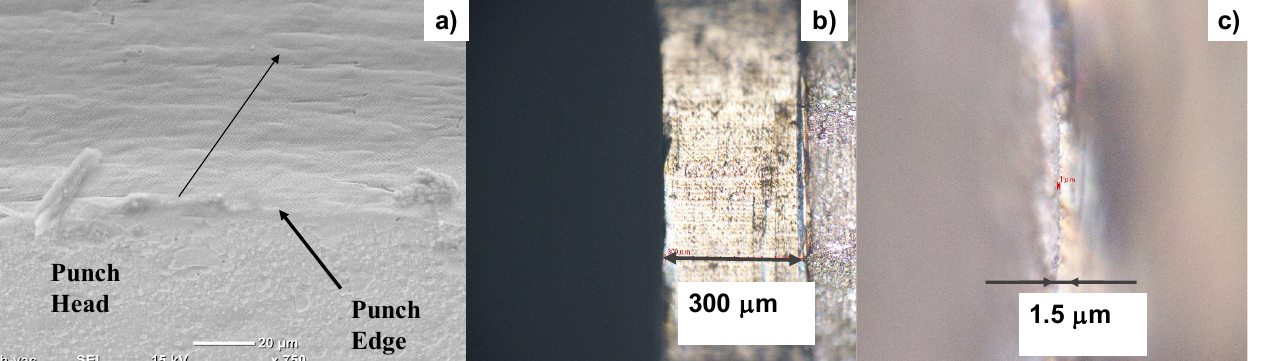
Figure 11. SEM and YAG-BSE images on the top and side surfaces of laser-trimmed SKD11 punch across its edge ( a , b ) in low magnification, and ( c , d ) in high magnification. 3.4. CNC Stamp Imprinting to Metallic Products An AA1060 aluminum plate with a thickness of 1mm with a normal flow stress of 200 MPa was employed. The CNC stamping system was utilized to imprint seven micro- textures with the tailored nano-textures onto this substrate. A single-mode loading se- quence was used to compress the upper punch with a constant velocity. Figure 12 depicts the embossed AA1060 aluminium plate after single-shot loading down to 150 μm from the original position where the punch touched just on the work material surface. This